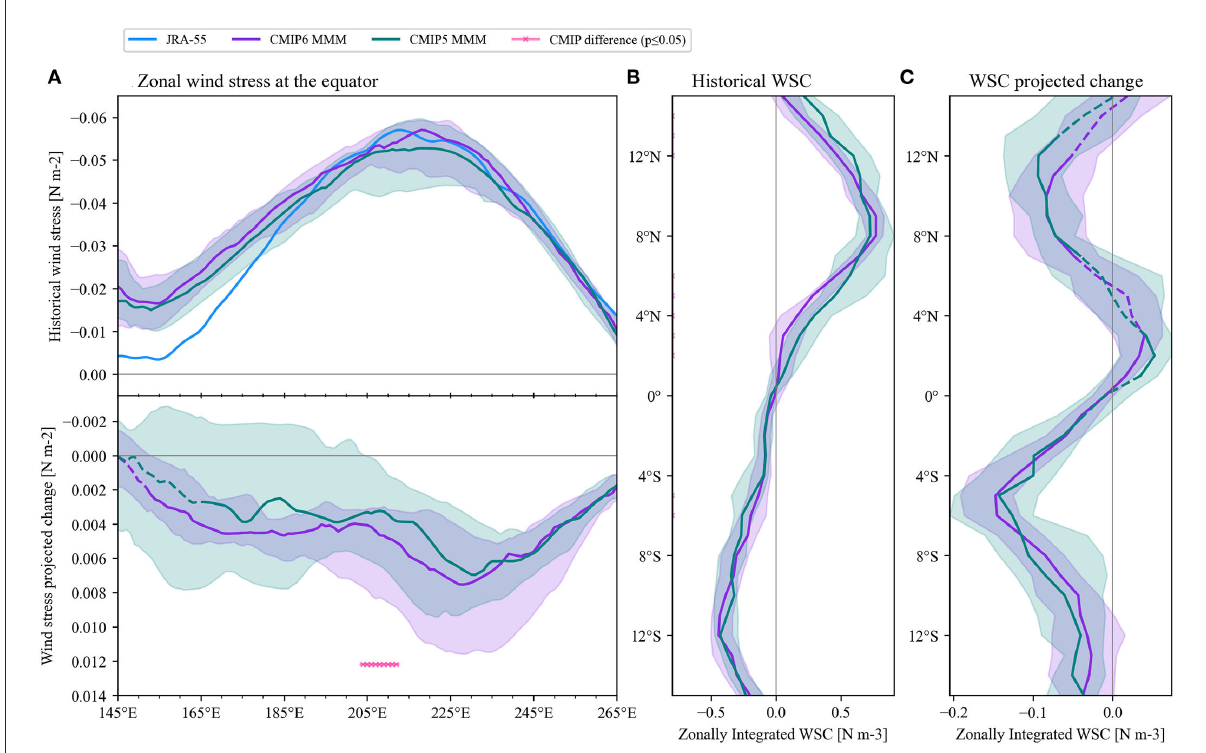
FIGURE5 Zonal wind stress and wind stress curl. (A) Zonal wind stress at the equator (mean ± 2 ◦ ) climatological historical mean (upper panel) and projected change (lower panel) as a function of longitude. Wind stress curl zonally integrated over the Pacific for the (B) historical mean and (C) projected change. Wind forcing estimates are shown for CMIP6 (purple) and CMIP5 (green) multi-model median (MMM; solid lines) and interquartile range (shaded) and the JRA-55 reanalysis product (blue lines). MMM projected changes that are not statistically significant are represented by dashed lines. Pink crossed lines indicate where differences between CMIP5 and CMIP6 are statistically significant. In (A) , easterly direction is represented by negative values ( y -axis reversed), and a corresponding positive projected change indicates a